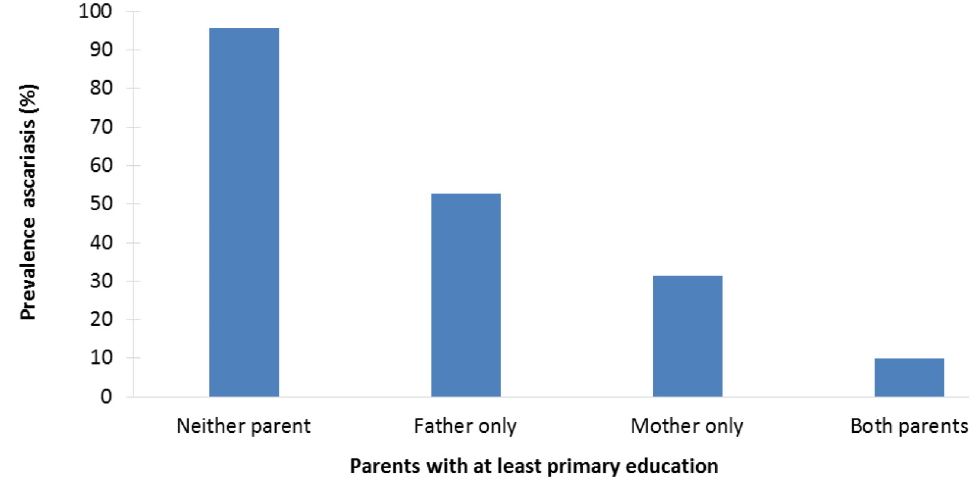
Fig 9. Example of socioeconomic inequalities in STH: parental education and ascariasis infection in a rural community in Osun State, Nigeria (2005 – 2006) [71]. A total of 440 children < 16 years of age from randomly selected households were included. Information on parental education was collected through a questionnaire, and faecal samples were examined for the presence of Ascaris eggs. The prevalence of ascariasis was statistically significantly higher among children of parents without a primary education ( p <